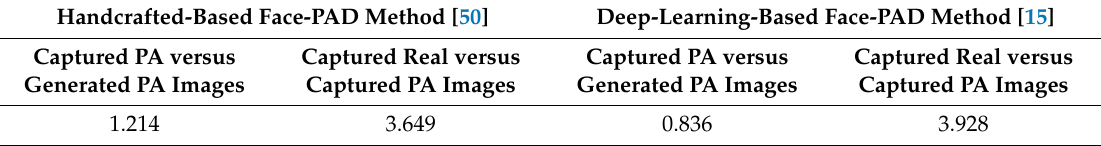
Figure 12 . Distribution of detection scores of captured real and generated PA images for the Replay- mobile dataset ( a ) using the handcrafted-based face-PAD method [50] and ( b ) using the deep-learning- based face-PAD method [15].